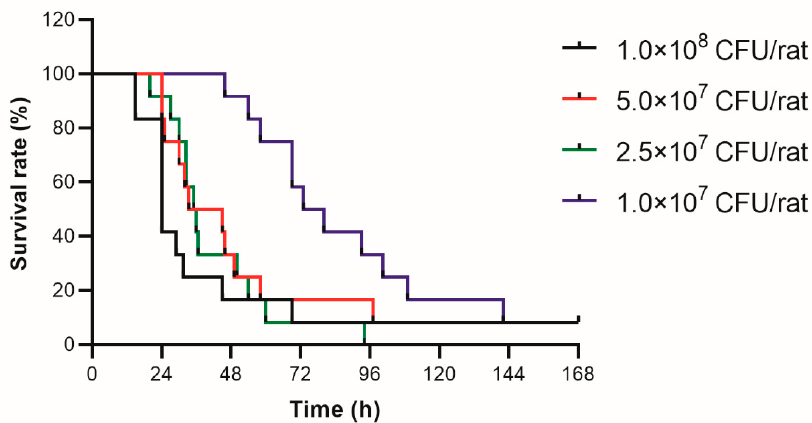
Figure 1. Survival curves of neutropenic rats 7 days after infection by intraperitoneal injection of one milliliter of different concentrations (1 × 10 8 CFU/mL, 5 × 10 7 CFU/mL, 2.5 × 10 7 CFU/mL, and 1 × 10 7 CFU/mL) of Pseudomonas aeruginosa ATCC9027.